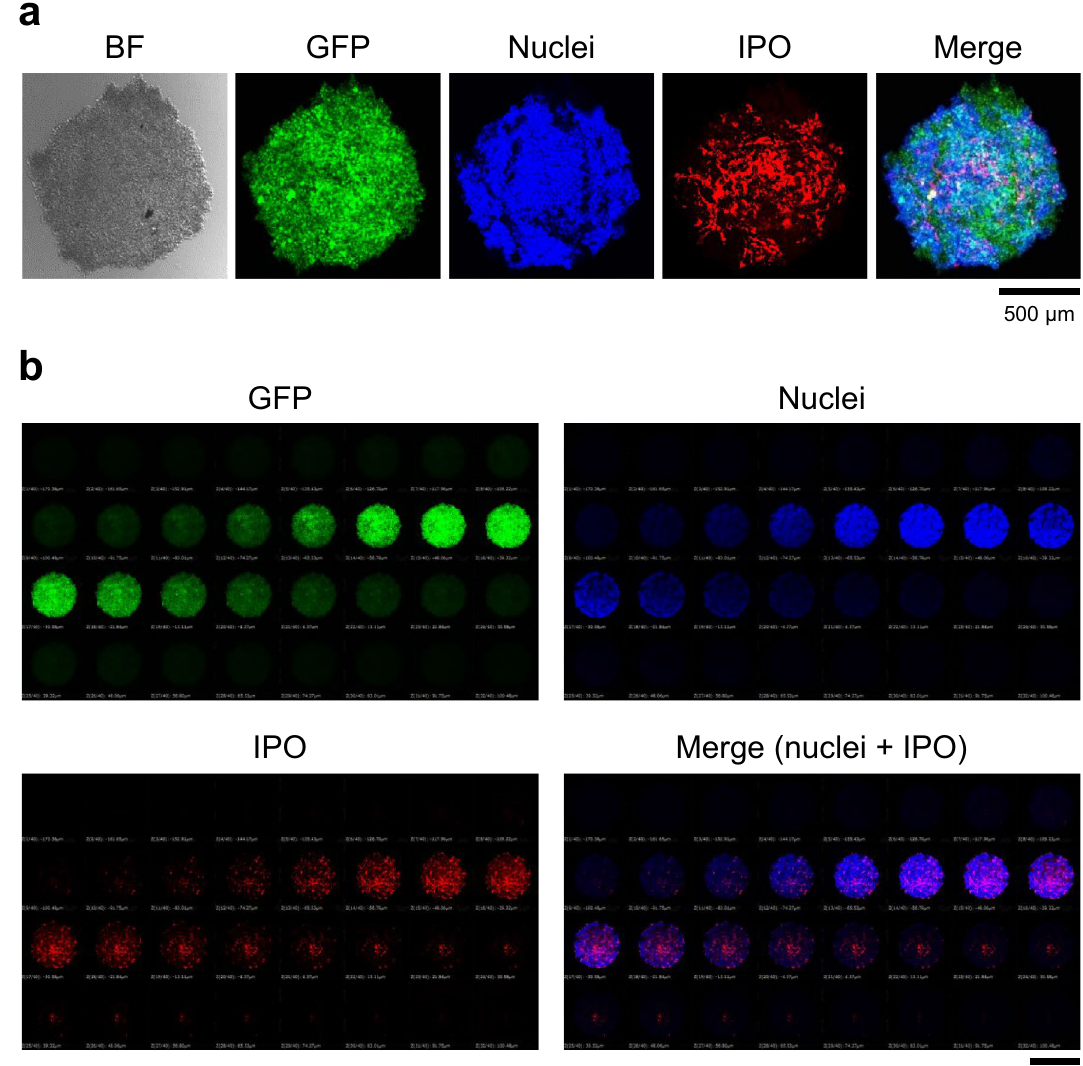
Figure 2. Uptake of IPO into tumor spheroids. ( a ) IPO nanoparticles were incubated with OVCAR8 tumor spheroids for 24 h, whose cells are engineered to express GFP. The tumor spheroids were washed and examined by confocal microscopy. The fluorescence of IPO labeled with rhodamine-B is shown in red. Nuclei were stained with Hoechst dye (blue). BF, bright field. ( b ) Fluorescence image at each focal